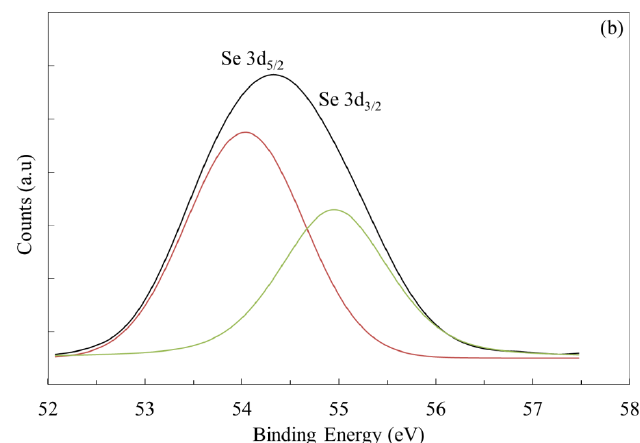
Figure 5. X-ray photoelectron spectroscopy (XPS) profile of ( a ) In ( b ) Se. Electronics 2017 , 6 , 27 The XPS binding energy of Sb 2 Se 3 is shown in Figure 6. The binding energies of Sb 3d 5/2 and 3d 3/2 are 529.83 eV and 539.03 eV as shown in Figure 6a. Detailed spectral deconvolution of the Se 3d high resolution XPS spectrum revealed that the binding energy of Se 3d 5/2 and 3d 3/2 are 54.43 eV and 55.23 eV, respectively, which is in good agreement with the expected binding energy of Sb 2 Se 3 [25]. These binding energies were corrected by referencing the C 1s peak to 284.70 eV.